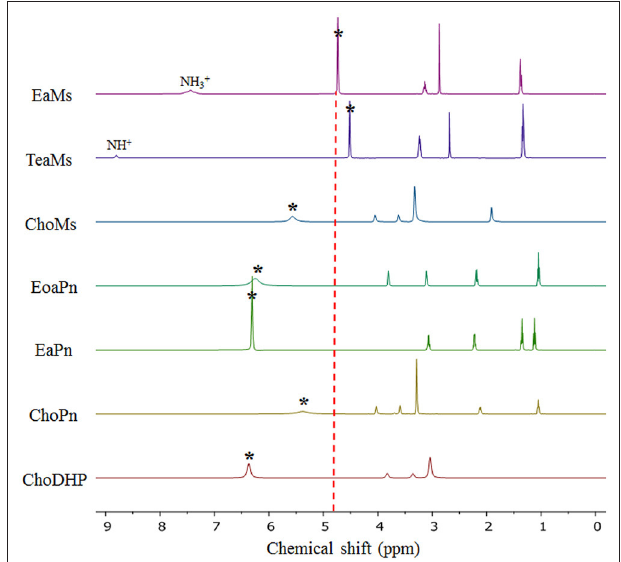
FIGURE 4 | NMR diagram of the hydrated ILs (25 mol%) at 20 ◦ C. The asterisk (*) refers to the signal of H 2 O in the ILs. The NH peaks of protic ILs were marked. The dotted vertical line represents the signal of neat H 2 O (4.80